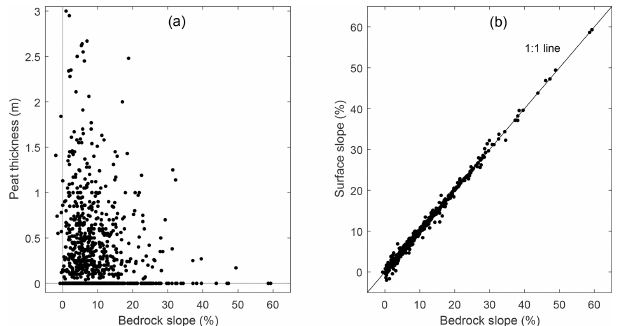
Figure 5. (a) Scatterplot of the measured peat thickness (m) as a function of the bedrock slope (%) and (b) scatterplot of the surface slope (%) as a function of the bedrock slope (%) for all coring loca- tions ( n = 866). The slope calculations are based on the measured coordinates of the coring